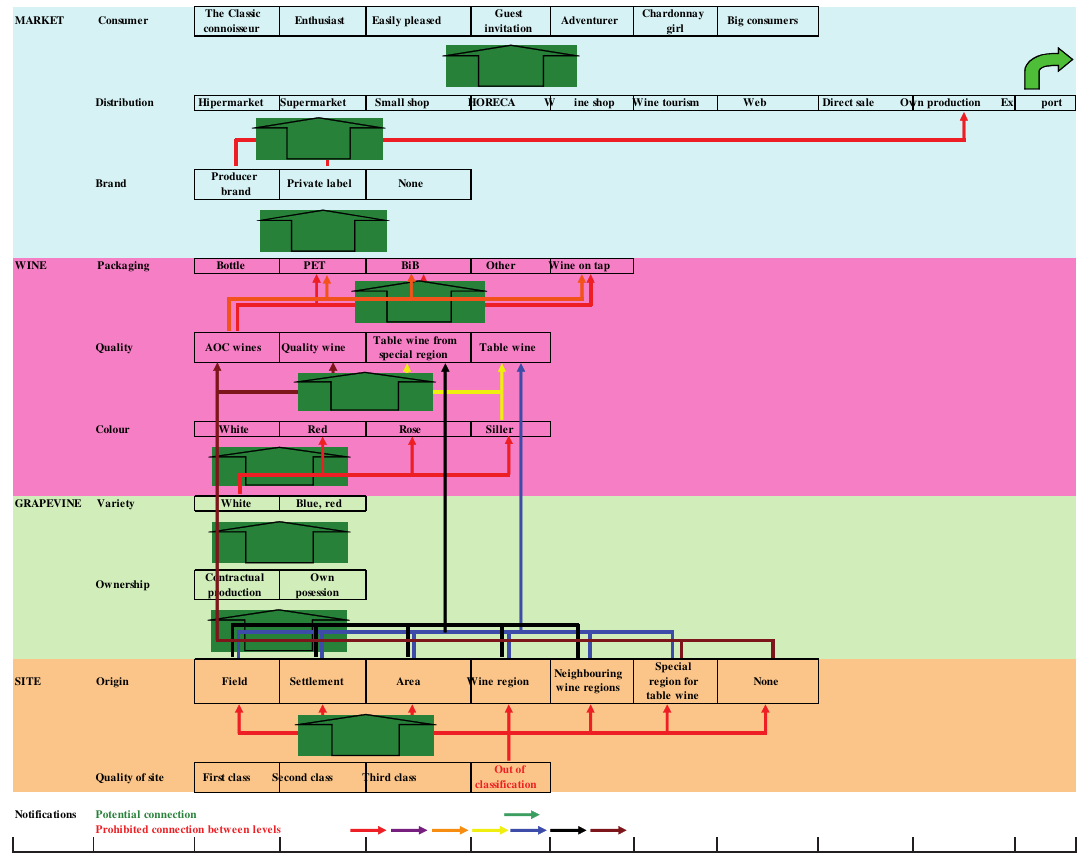
Figure 2. Vertical base model of Hungarian wine